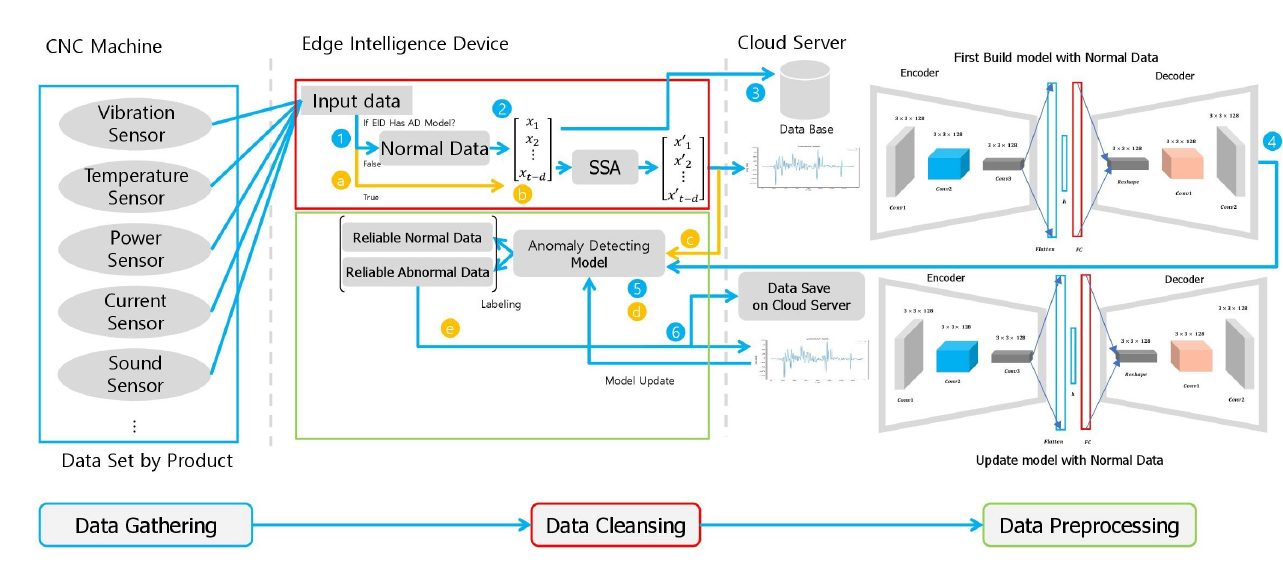
Figure 5. Architecture of SSA-CAE based Abnormal Data Classification Techniques in Edge Intelli- gence Device.